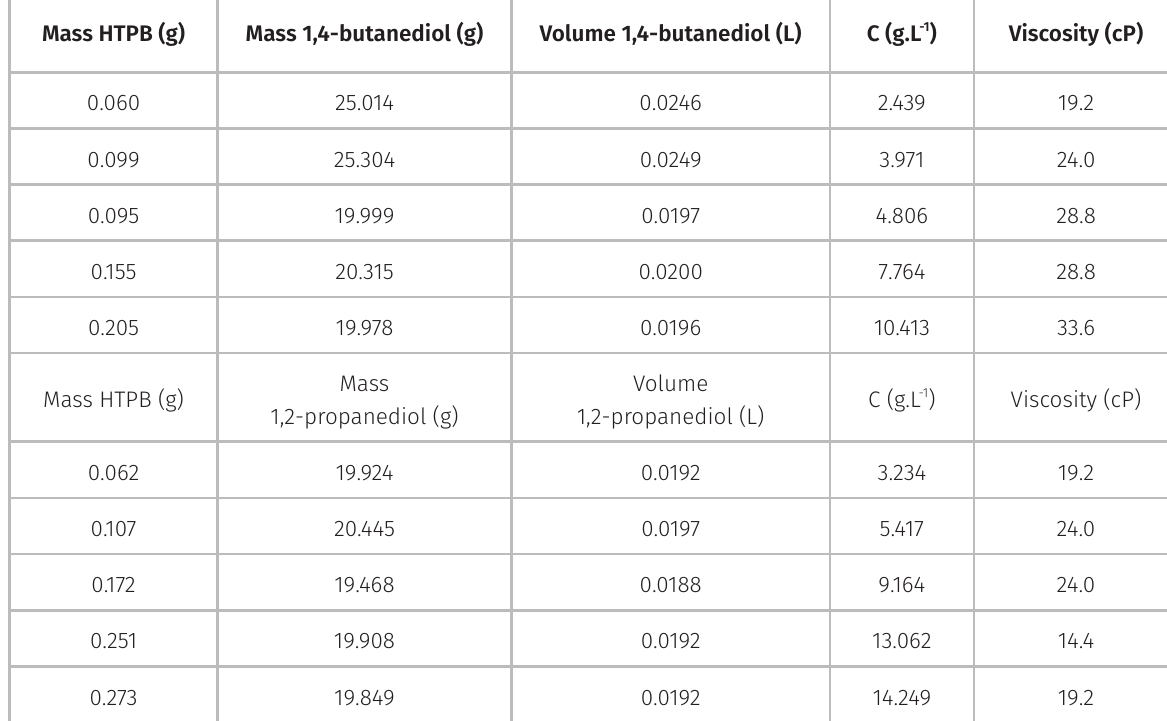
Table II. Viscosity data for diluted resin solutions in 1,4-butanediol or 1,2-propanediol. Mass HTPB